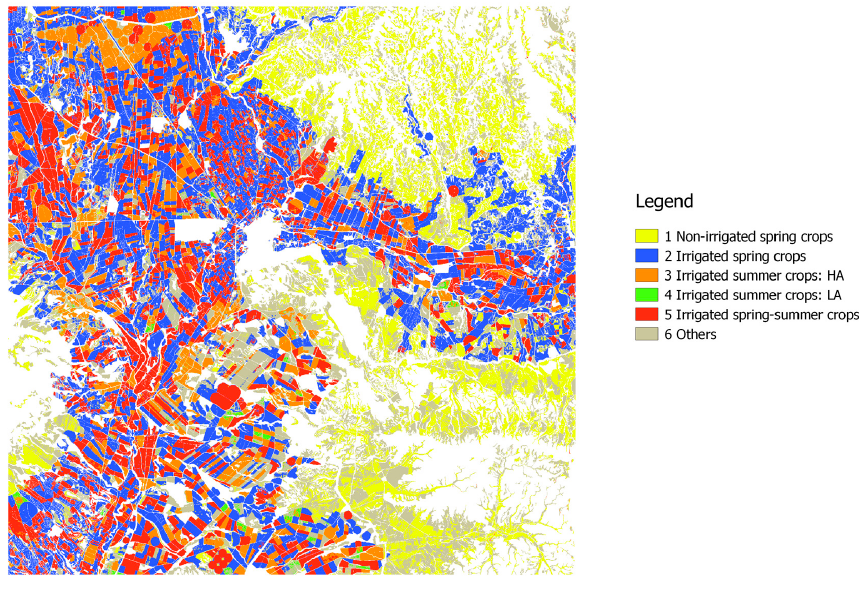
Figure 7. TS1 Irrigation map.